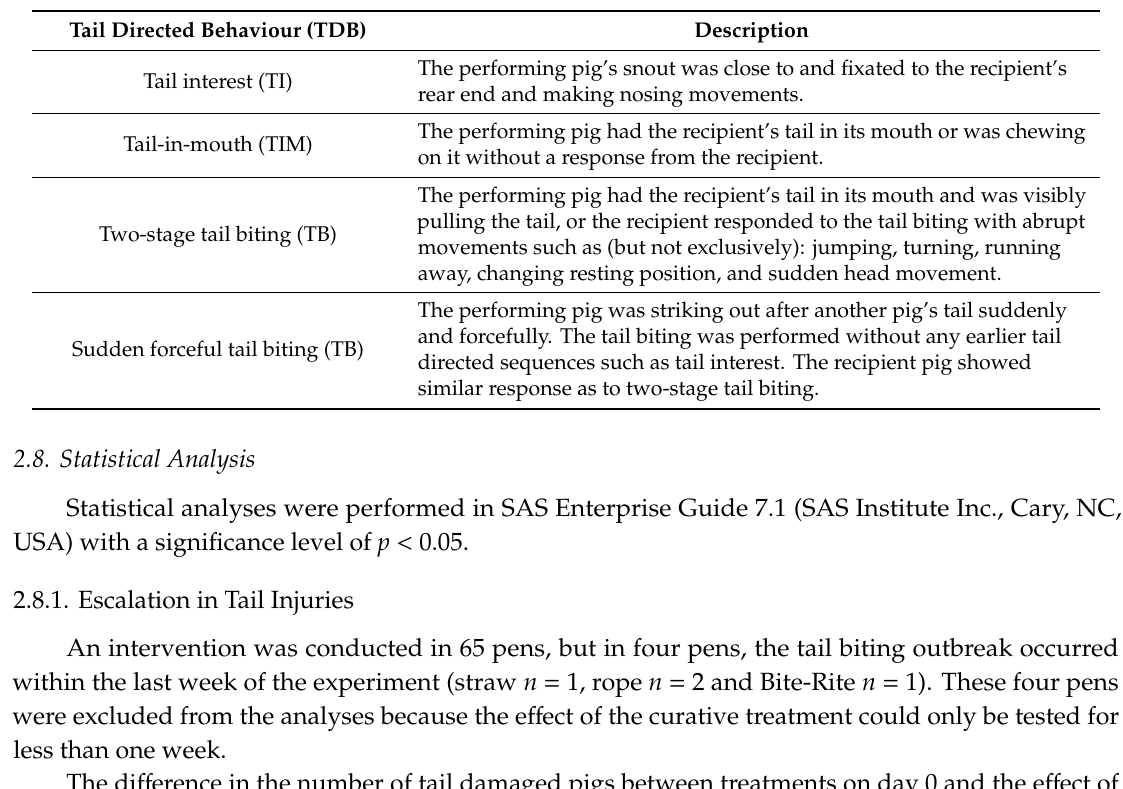
Table 3. Ethogram describing tail directed behaviours recorded during continuous sampling. Based on Taylor et al. [18] and Zonderland et al.